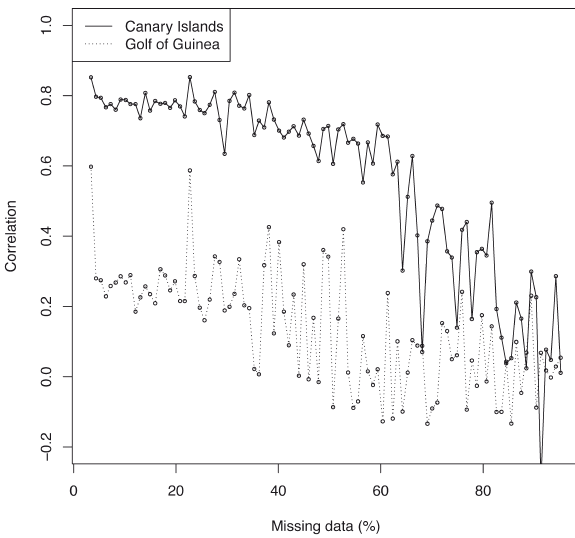
Fig . 8. – Correlation between original and reconstructed data in the Canary Islands and the Gulf of